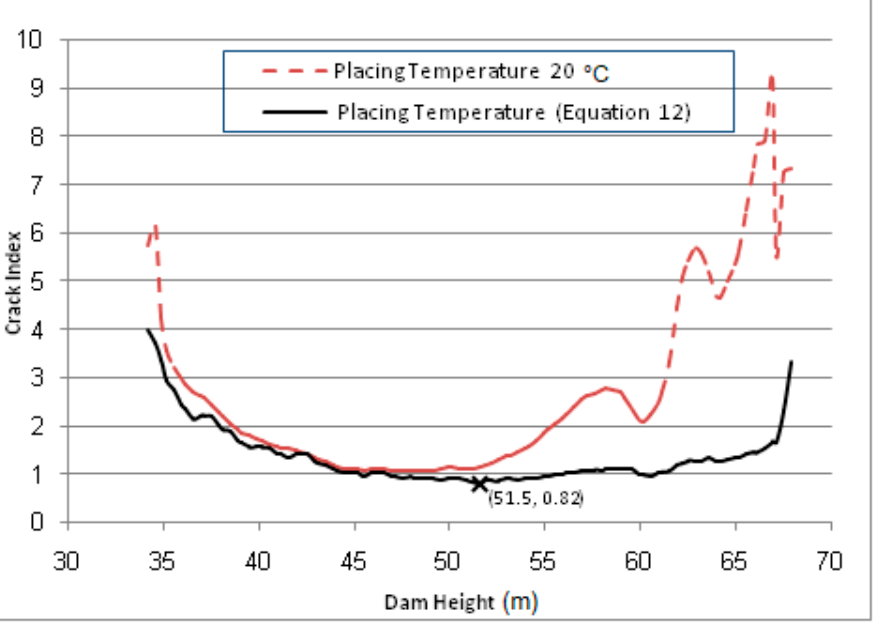
Figure 11. Crack index variation along the downstream outer Gaussian points.